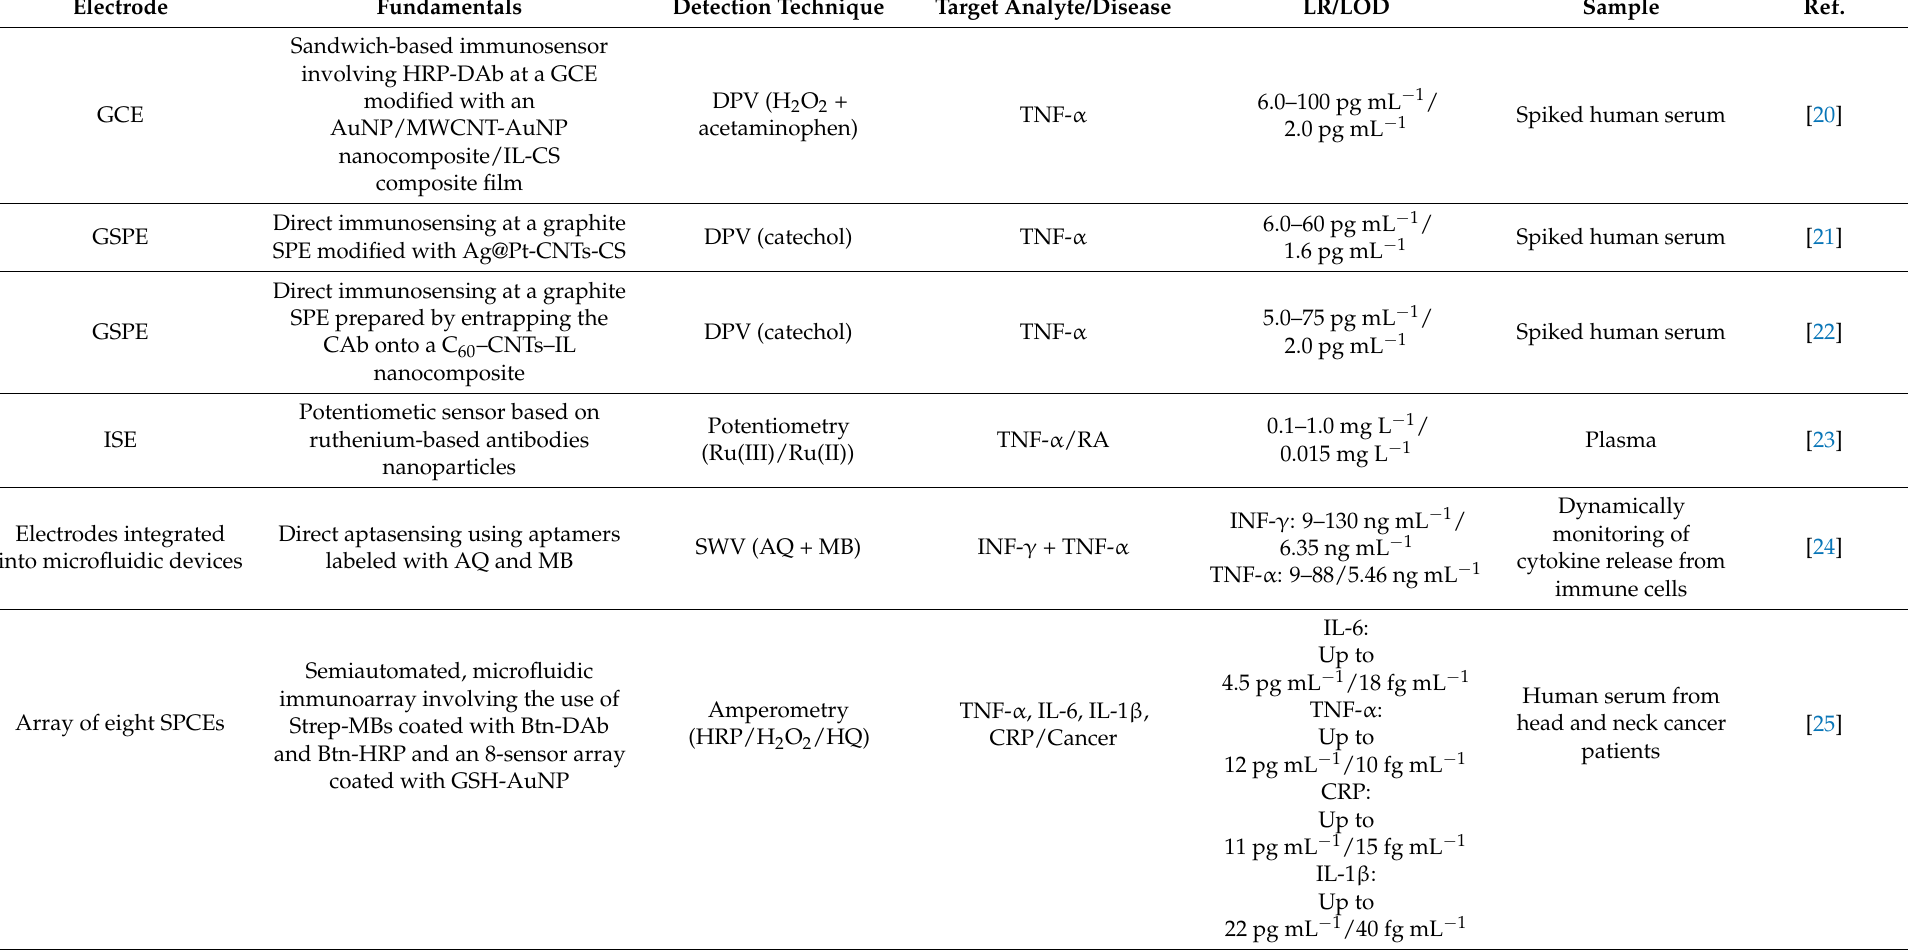
Table 2. Electrochemical biosensing methods reported since 2015 for the determination of inflammatory